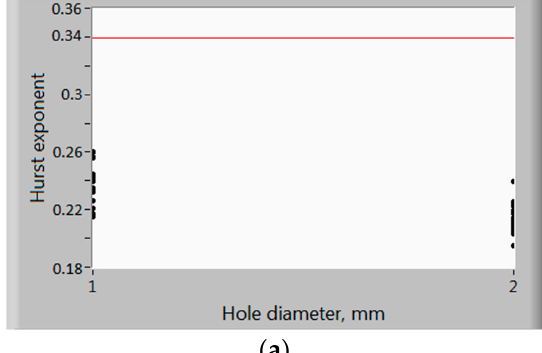
Figure 10. Values of the Hurst exponent at a pump discharge pressure of 3.5 bar: ( a ) for X-axis signals, ( b ) for Y-axis signals.